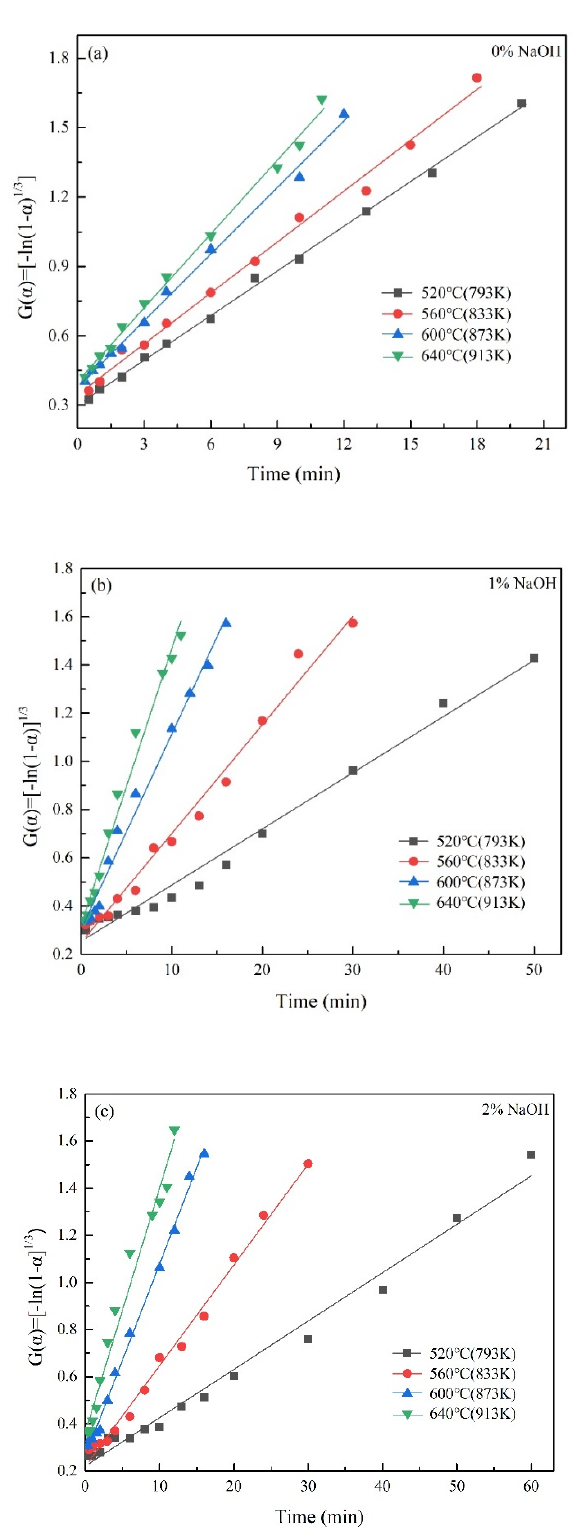
Figure 6. Linear regression analysis curves between mechanism function G( α ) of A3 model and experimental data (( a ) 0% NaOH, ( b ) 1% NaOH, ( c ) 2% NaOH).